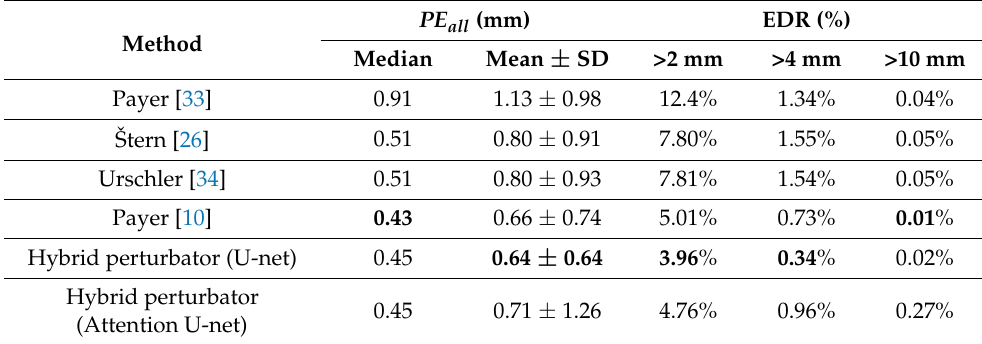
Table 5. Quantitative comparison with existing methods on the Digital Hand Atlas